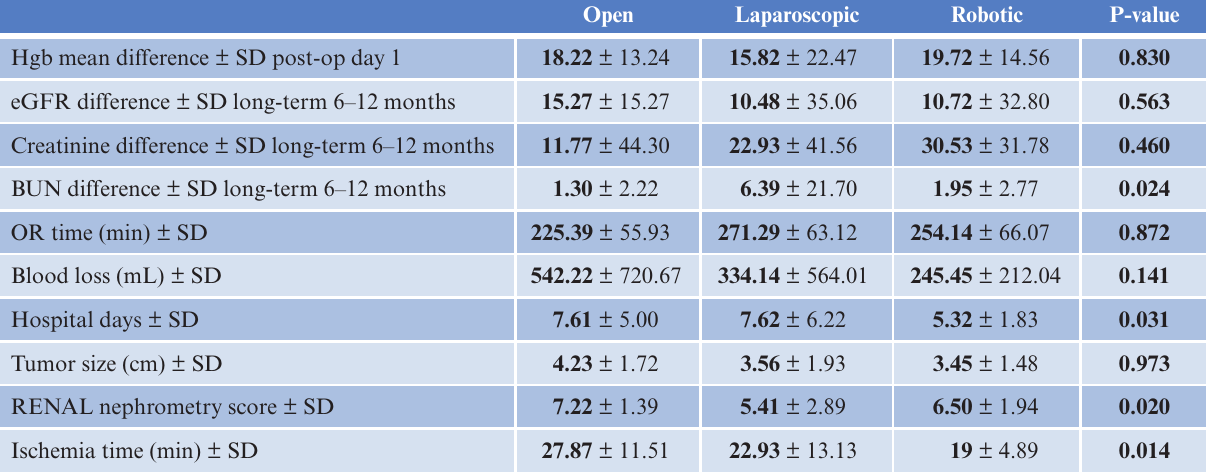
Table 3: Comparing groups for pre-operative and post-operative follow-up mean values for hemoglobin (Hgb), glomerular filtration rate (GFR), creatinine, and blood urea nitrogen (BUN), and mean values of operating room (OR) time, blood loss, hospital stay, tumor size, RENAL nephrometry score, and Ischemic time. Open Laparoscopic Robotic